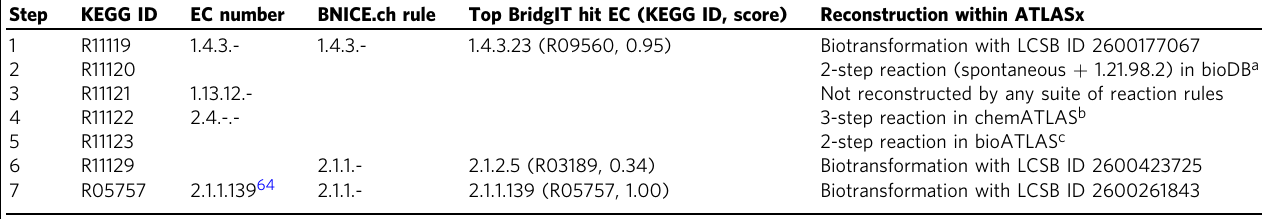
Table 2 Pathway reconstruction and gap- fi lling of the staurosporine biosynthesis pathway with